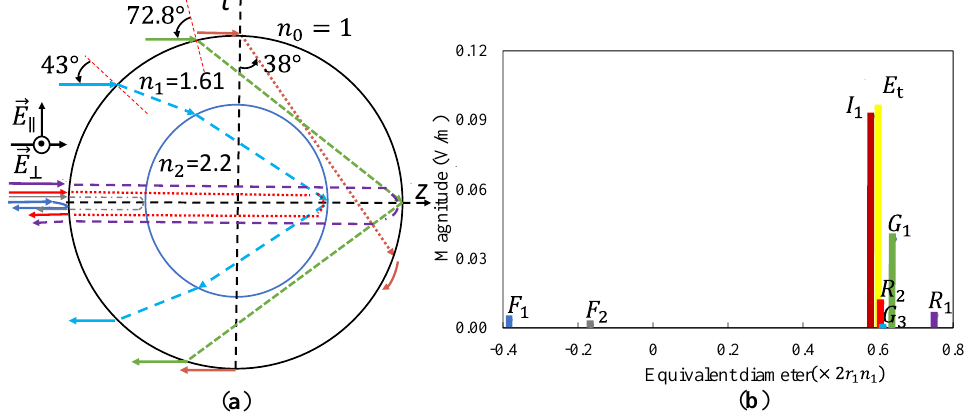
Figure 5. Backscattered wave for LCS 1: ( a ) Propagation of the backscattered wave components; ( b ) Magnitude and phase center of the backscattered wave components.